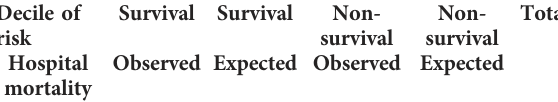
TABLE 3 Example of Hosmer – Lemeshow goodness of fi t test. Decile of Survival risk